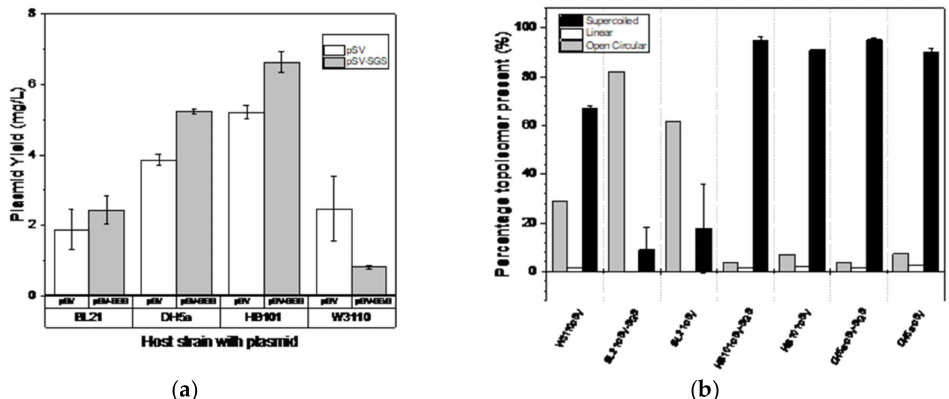
Figure 1. Plasmid yield and supercoiling of pSV β -gal398 (pSV-SGS) and pSV β -gal (pSV) amplified in the four strains. All analyses were done in triplicates. ( a ) The total plasmid yield (mg / L) of pSV β -gal398 and pSV β -gal amplified in the four strains and ( b ) percentage supercoiled topoisomer content of plasmid extracted from the four strains used. The di ff erences observed were tested statistically with p < 0.05.